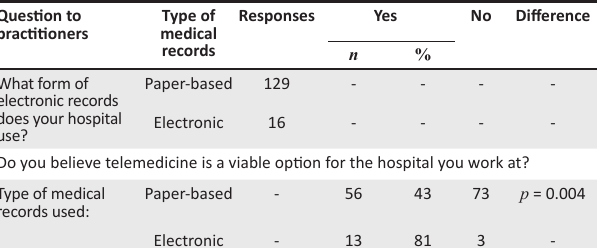
FIGURE 3: Perceptions of viability of telemedicine across TABLE 3: Perception of viability based on type of medical records used.